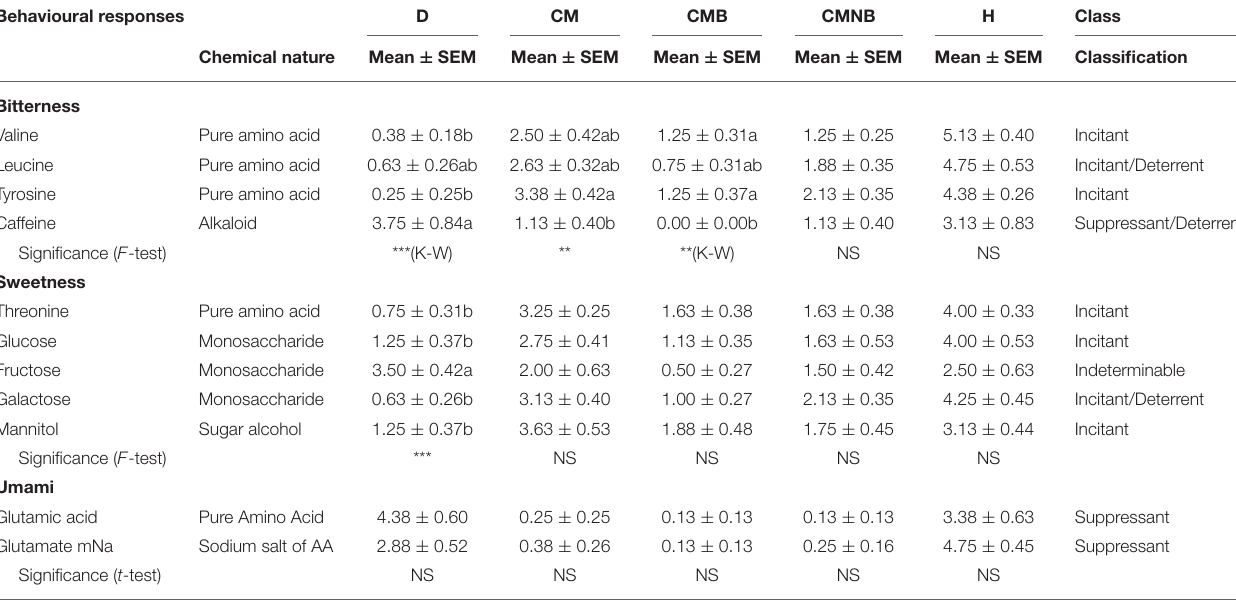
TABLE 6.4 | Comparisions of selected chemical stimuli related with tastes. Behavioural